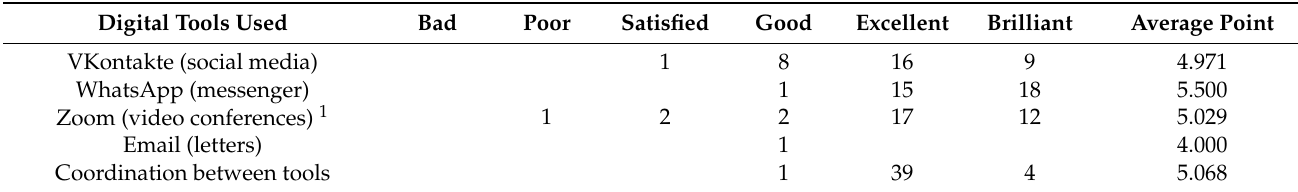
Table A7. Points awarded by students for digital tools applied, December 2020 (N3 = 34).